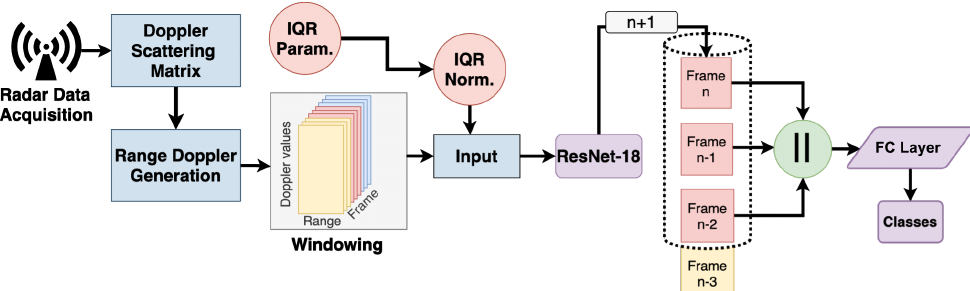
Figure 1. Flow diagram of the inference pipeline of the proposed approach. n represents the frame counter. The Doppler data are fed to the ring buffer frame by frame. Three frames, which represent roughly one second, are then concatenated. The concatenated frame data are further forwarded to the fully connected (FC) layer of the